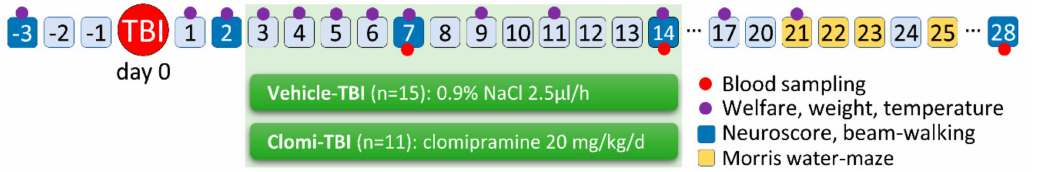
Figure 6. In vivo study design. Lateral fluid-percussion-induced (FPI) traumatic brain injury (TBI) was performed on day 0. Treatment with vehicle (Vehicle-TBI group, n = 15) or clomipramine (Clomi-TBI group, n = 11) was initiated between 08:00–12:00 at 3 days post-TBI via subcutaneous osmotic minipumps and discontinued between 08:00–12:00 at 14 days by removing the minipumps. Functional outcome was assessed by composite neuroscore and beam-walking tests before TBI (baseline) and at 2, 7, 14 and 28 days post-TBI. Spatial learning and memory were assessed with the Morris water-maze at 21–23 days and 25 days post-TBI. Tail vein blood was collected at 7, 14 and 28 days to assess plasma cytokine levels as monitoring biomarkers. General animal welfare was monitored 3